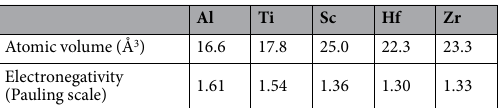
Table 1. Atomic volumes and electronegativities of the constituent elements of the investigated HEA as obtained from the CRC handbook of elements 71 . The atomic volumes have been calculated from the lattice parameters of the stable phases at ambient